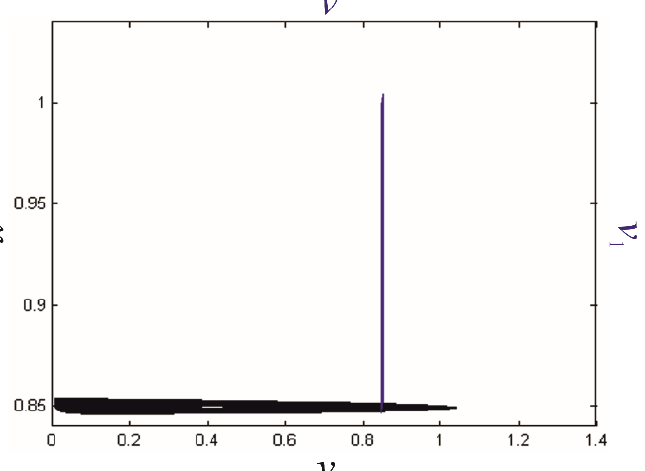
Figure 16. Master ( v , x )—black color, and master–slave ( v , v 1 )—purple color phase portraits.